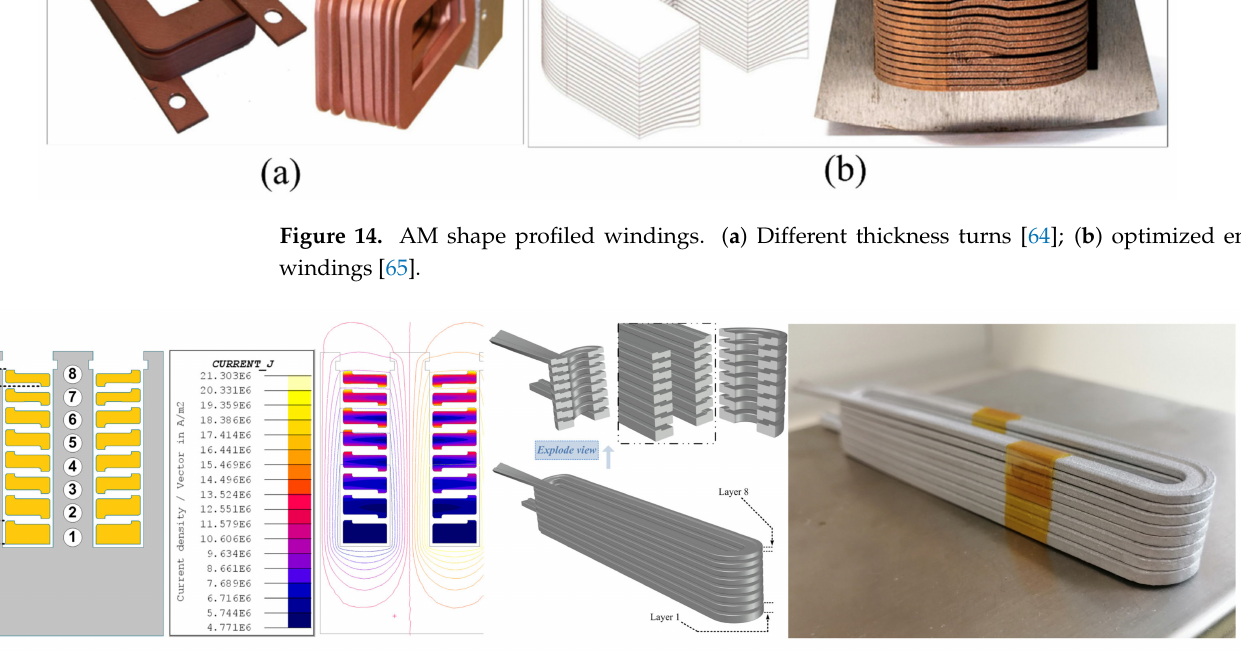
Figure 15. AM shape profiled windings with uneven layers for weight sensitive applications